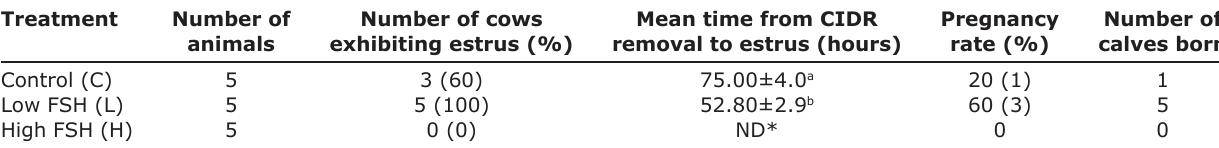
Table-1: Effect of administration of r-hFSH on the estrus exhibition and pregnancy rate in dairy cows. Treatment Number of Number of cows Mean time from CIDR animals exhibiting estrus (%) removal to estrus (hours)